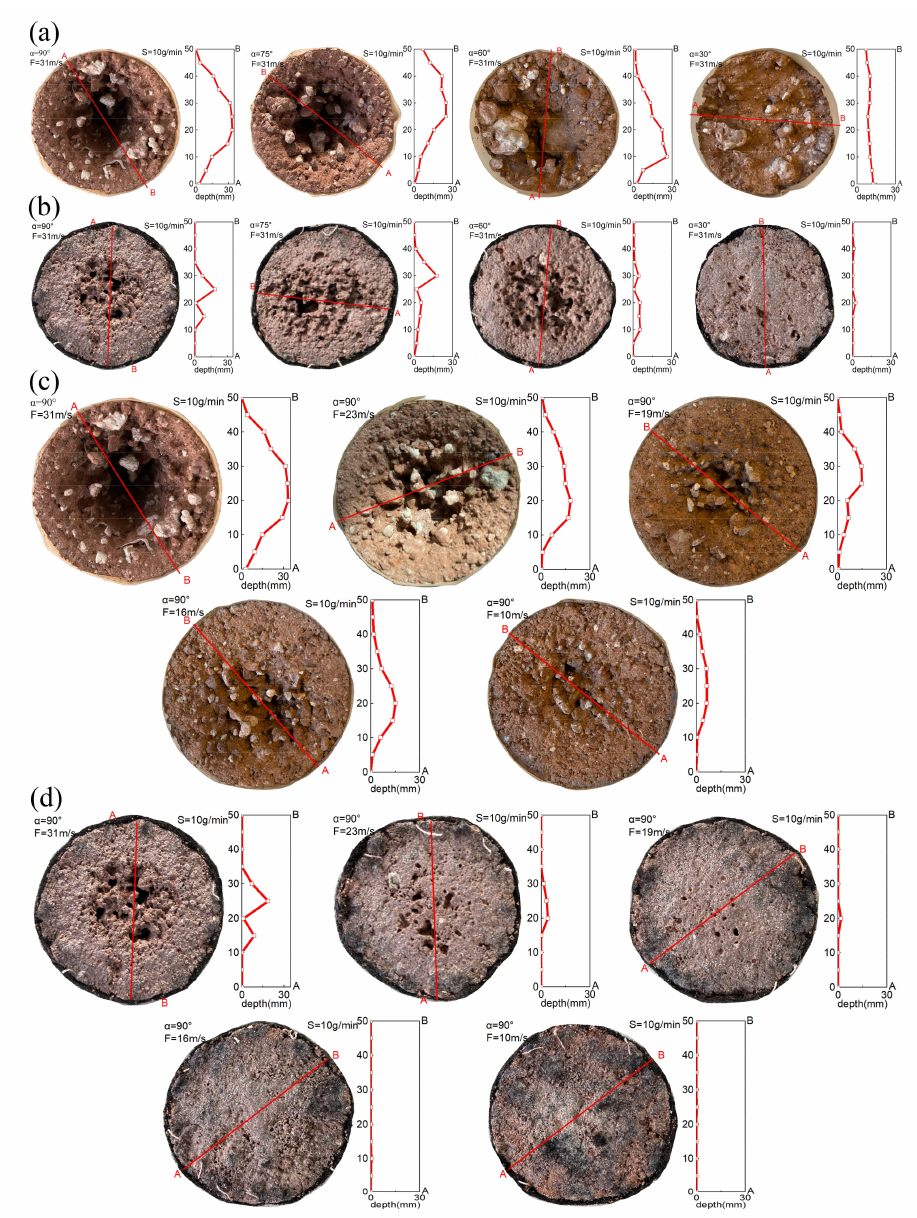
Figure 12. Images of erosion pits: ( a ) remolded soil; ( b ) improved soil; ( c ) remolded soil; ( d ) improved